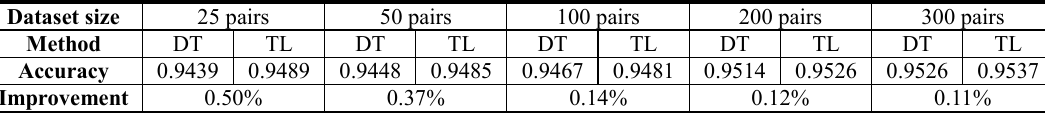
Table 4. The test accuracy on different size of training samples. DT means directly training on the dataset with random initial weights, while TL means transfer learning.